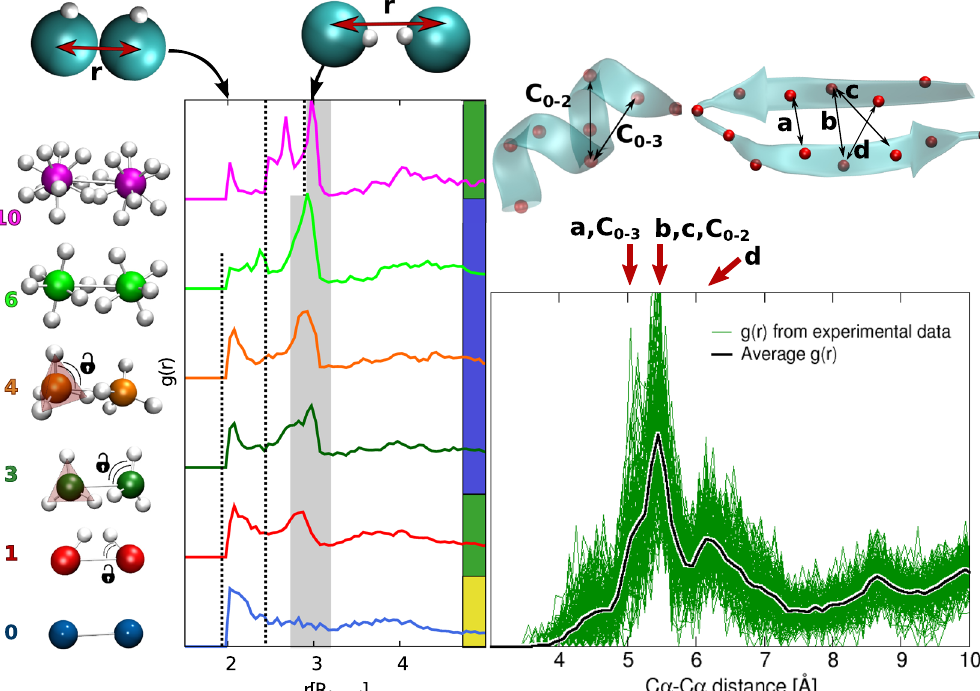
Figure 2. ( a ) Radial distribution functions g ( r ) for patchy polymers. We show one g ( r ) curve for each patch arrangements because we observed that it does not change significantly for different alphabet sizes. The g ( r ) has been averaged on the 40 most probable conformations for different patches arrangements (y-axis): white spheres indicate the patches located at the surface of the monomer. The g ( r ) are y-shifted for the sake of visualisation. The random packing peak is delimited by two dashed lines, while the grey band highlights the range of the directional peak. Note that for 10 patches the random packing peak splits and moves towards larger distances (Supp. Mat. Fig. 4). The ratios between the random packing peak and the directional peak areas are: 0.75 for 1 patch, 0.23 for 3 patches, 0.27 for 4 patches, 0.22 for 6 patches, and 1.33 for 10 patches. ( b ) g ( r ) calculated over the C α – C α distances for 145 high resolution protein structures from the Protein Data Bank (green lines). The thick black line is the average. The first peaks dominating the g ( r ) correspond to the characteristic distances of the backbone hydrogen bonds, which determine the secondary structure 64 ( α -helix and β -sheet shown on top). All g ( r ) have been calculated by neglecting the contribution of the first neighbour along the